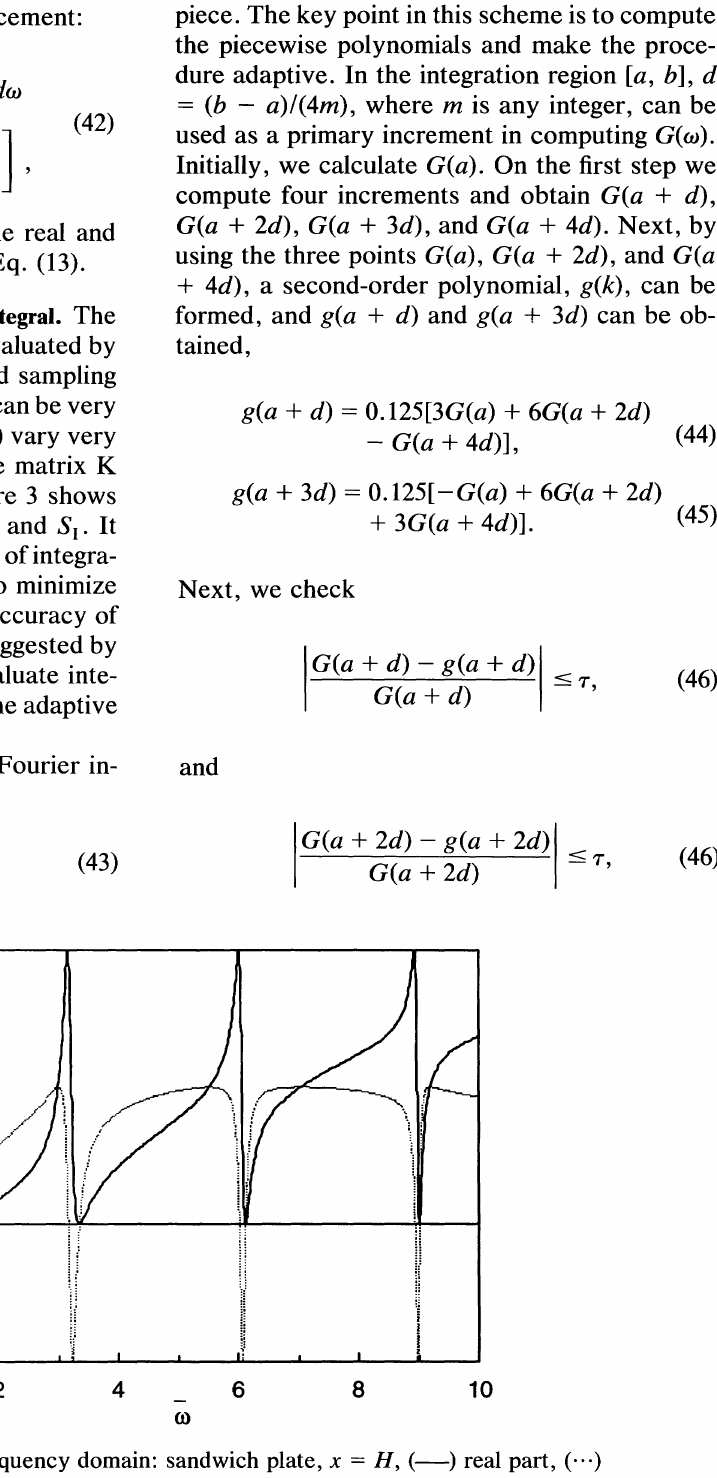
FIGURE 3 Stress in the frequency domain: sandwich plate, x = H, (-) real part, ( ... ) imaginary